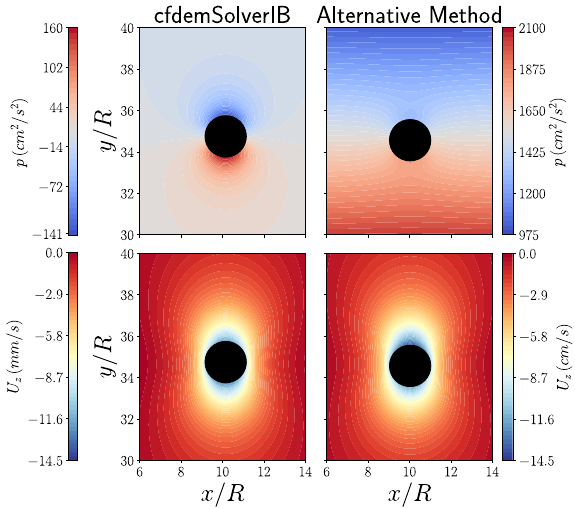
Figure 1. Comparison of p /ρ f and U z fields for our approach and cfdemSolverIB [7]. a) and b) represent the pressure field, c) and d) the velocity field U z .